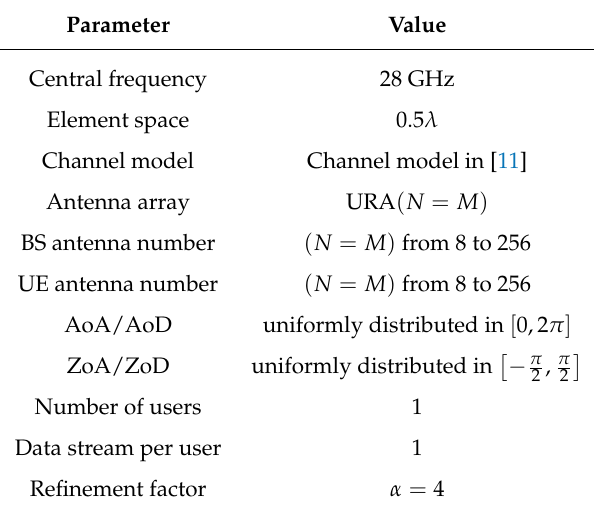
Table 3. Simulation parameters